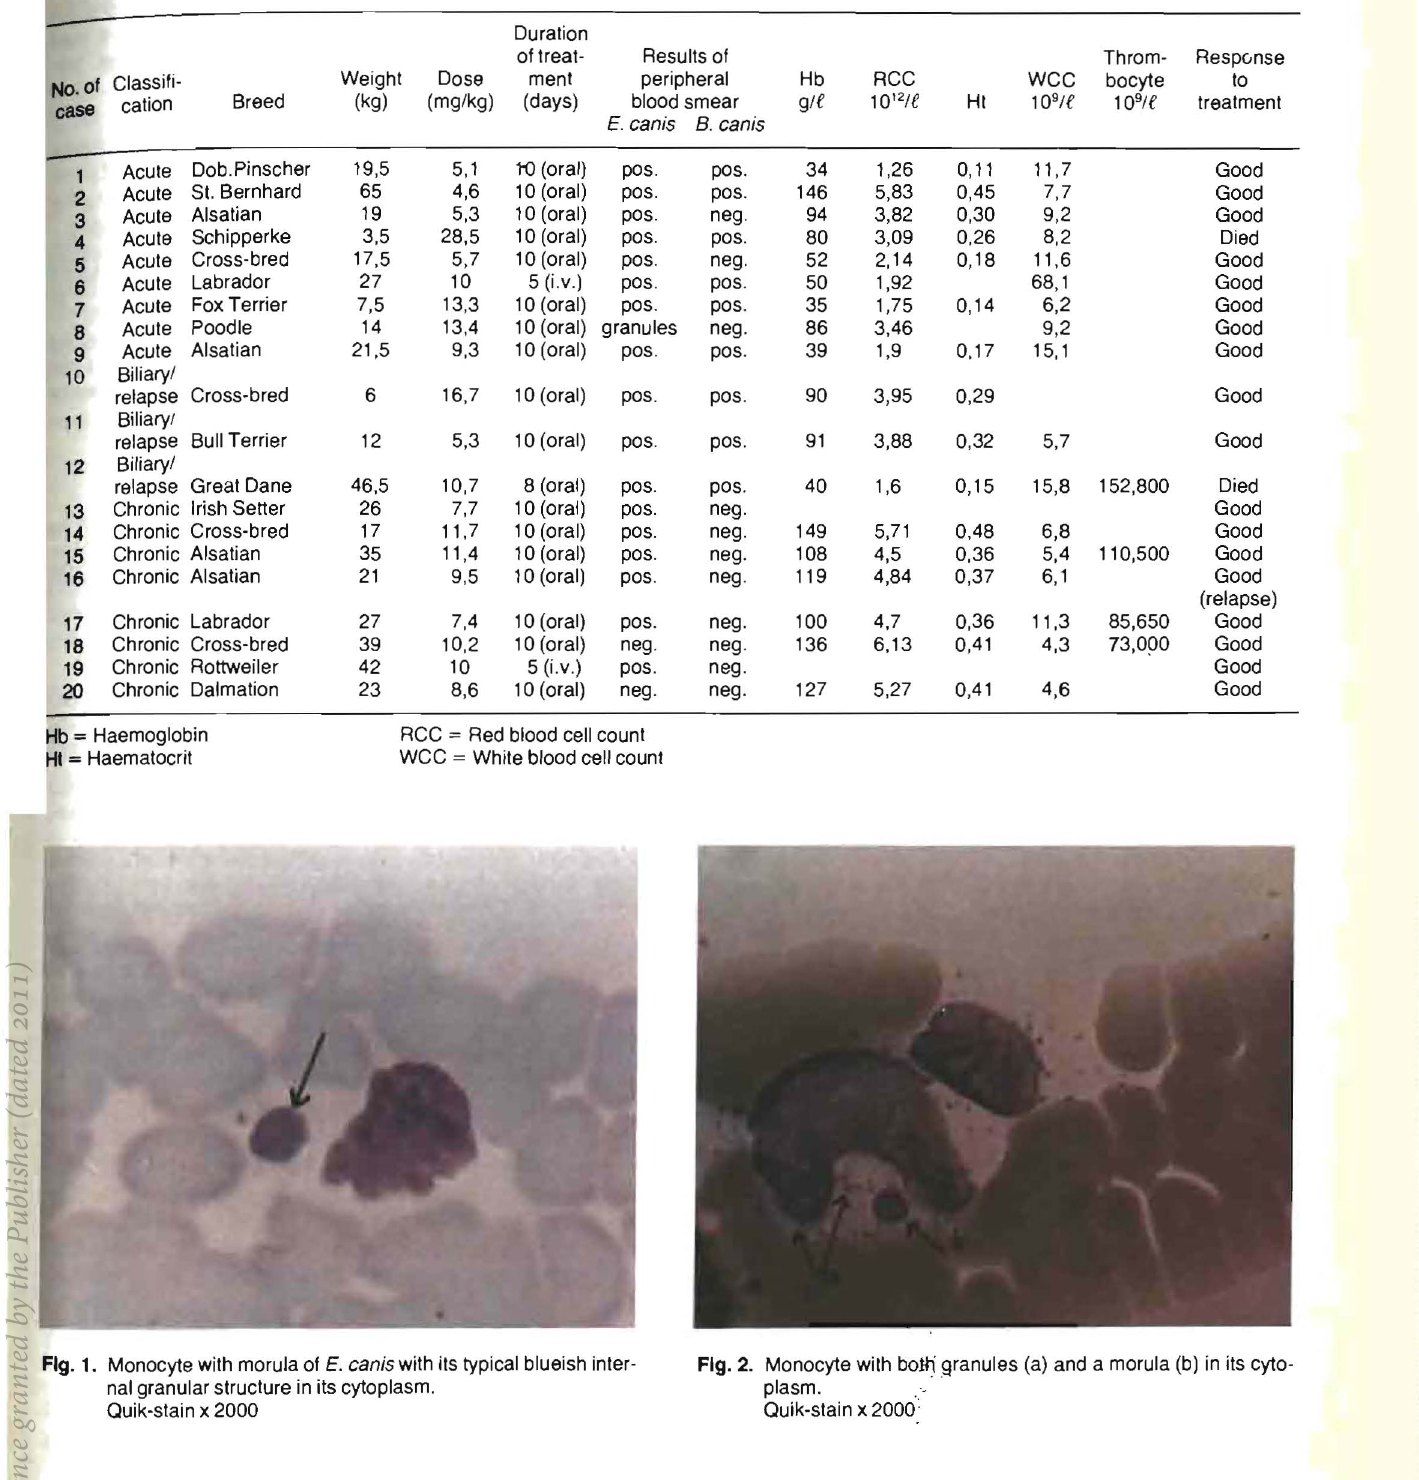
Fig. 1. Monocyte with morula 01 E. canis with its typical blueish inter nal granular structure in its cytoplasm. Quik-stain x 2000